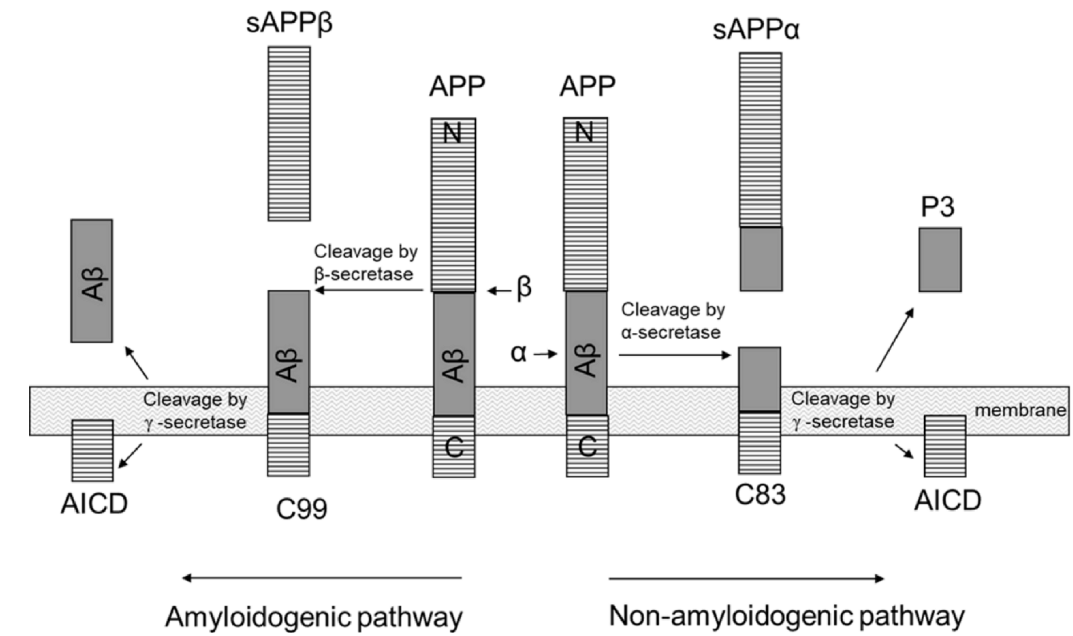
Figure 4. APP cleavage scheme in two